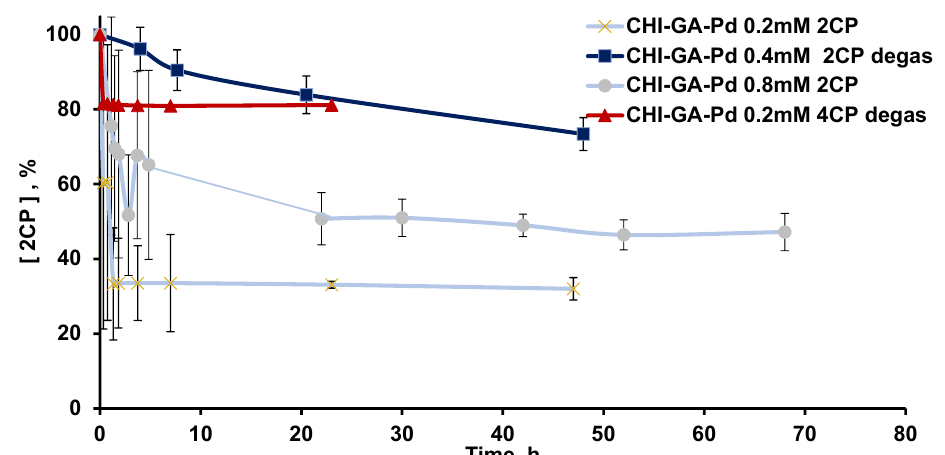
Figure 7. Kinetic curves of chlorophenols (50 ppm) decomposition catalyzed by CHI-GA-PdNPs without degassing of the reaction mixture, UV-vis monitoring PdNPs-CHI-GA 0.2 mM (4.9 µg PdNPs) and 0.8 mM (45 µg PdNPs) and PdNPs-CHI-GA 0.2 mM after additional degassing applying vacuum of reaction mixture at time point 16 h. GC-MS and HPLC analysis was used to monitor the kinetics of the catalytic decom- position process. According to the literature data, chlorophenols are reduced to benzene,